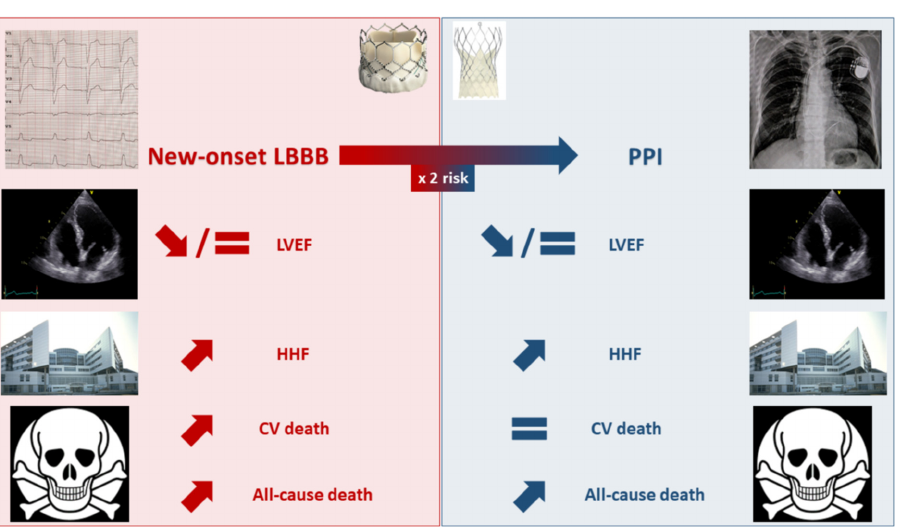
Figure 1. Effects of new-onset left bundle branch block and permanent pacemaker implantation on transcatheter aortic valve replacement outcomes. CV: cardiovascular; HHF: hospitalization for heart failure; LBBB: left bundle branch block; LVEF: left ventricular ejection fraction; PPI: permanent pacemaker implantation.